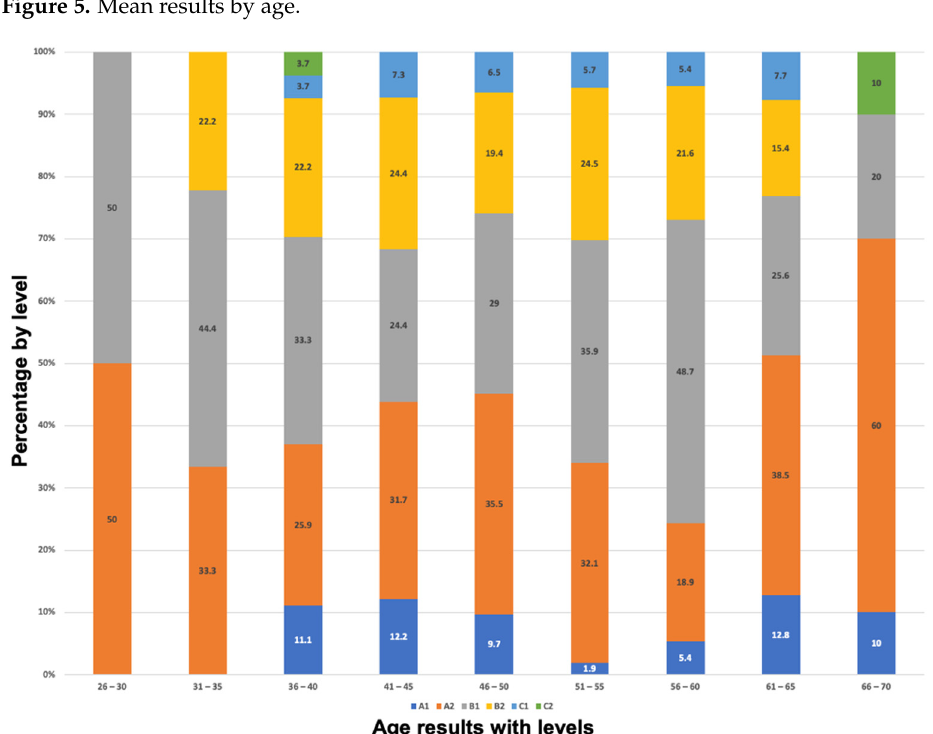
Figure 6. Percentage of each level according to age.